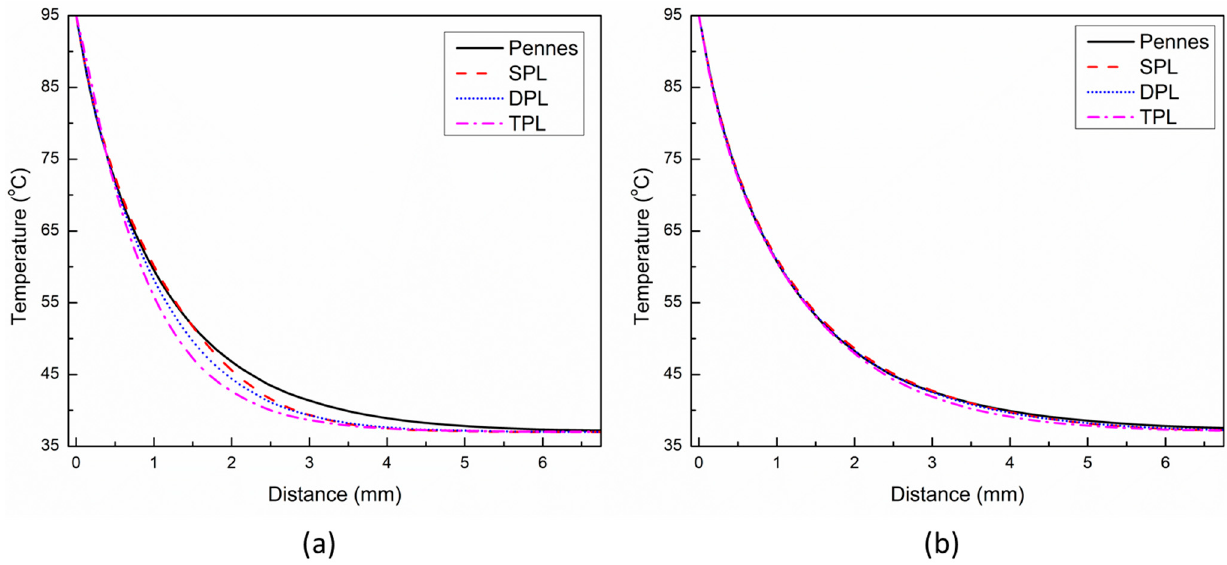
Figure 4. Temperature distribution predicted with different bio-heat transfer models along the line below the tip of the applicator at: ( a ) 30 s, and ( b ) 60 s.